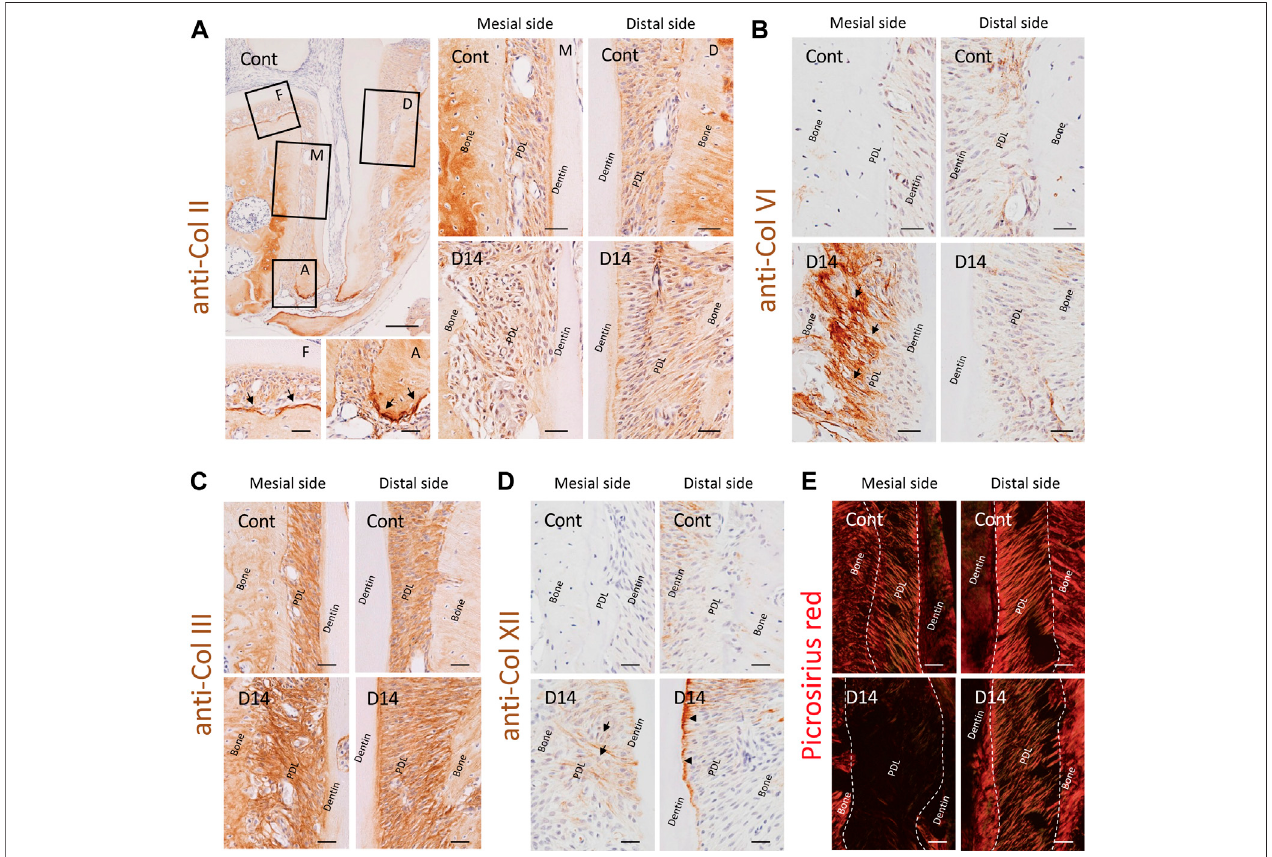
FIGURE 6 | Effect of mechanical loading on collagen distribution in the mouse molar PDL. (A) Distribution of type II collagen in the PDL. Type II collagen was distributed throughout the PDL space, and intense staining was observed at the mineralized tissue surface, particularly at the bone surface of the furcation area and cementum surface of the apical area (arrows). F, furcation area; A, apical area; M, mesial side; D, distal side. (B) Distribution of type VI collagen in the PDL. Staining intensity of type VI collagen markedly increased along with that of the collagen fi bers at the mesial side of the PDL, speci fi cally at the bone side (arrows). (C) DistributionoftypeIIIcollageninthePDL. (D) DistributionoftypeXIIcollageninthePDL.StainingintensityoftypeXIIcollagenwasincreasedatthenewlyformed fi berson the mesial side of the PDL (arrows) and at the cementum surface on the distal side of the PDL (arrowheads) on day 14. (E) Polarized observation of picrosirius red staining, detecting matured collagen fi bers. Scale bars: 200 μ m at low magni fi cation (a, top left) and 50 μ m at high magni fi cation (all other images).